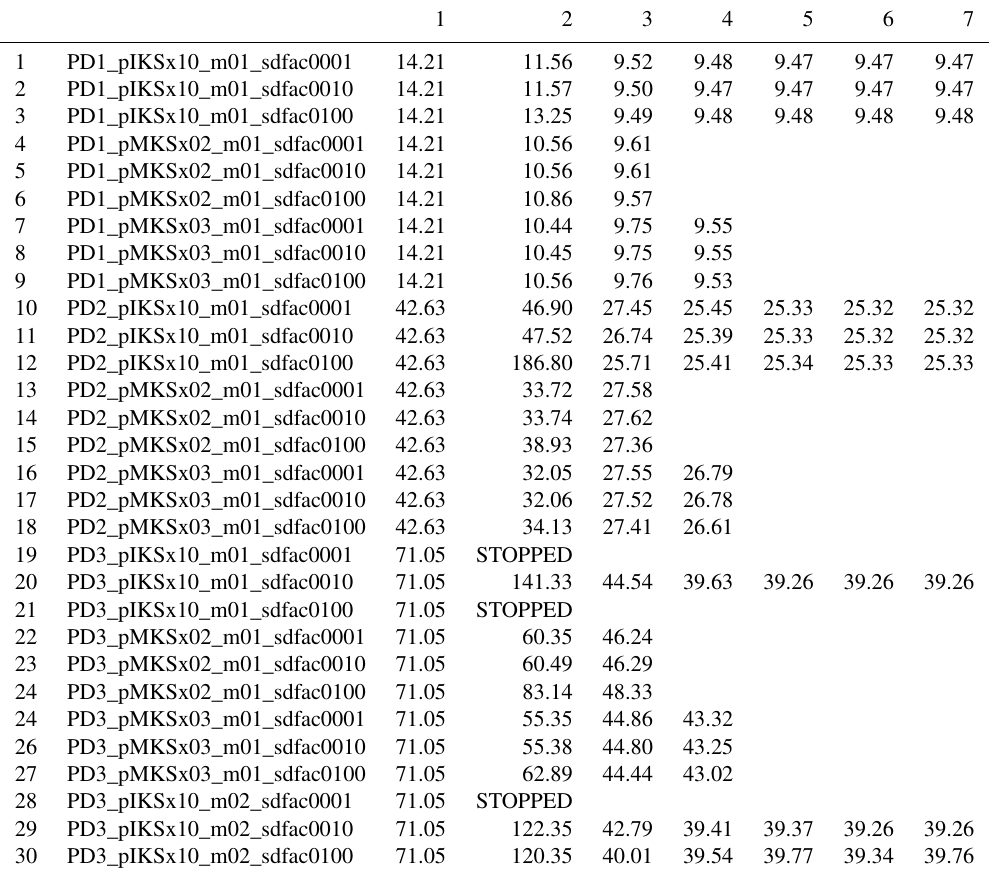
Table A1. 1-D energy balance model experiment. Cost function values for the tests with the FDS schemes ∗